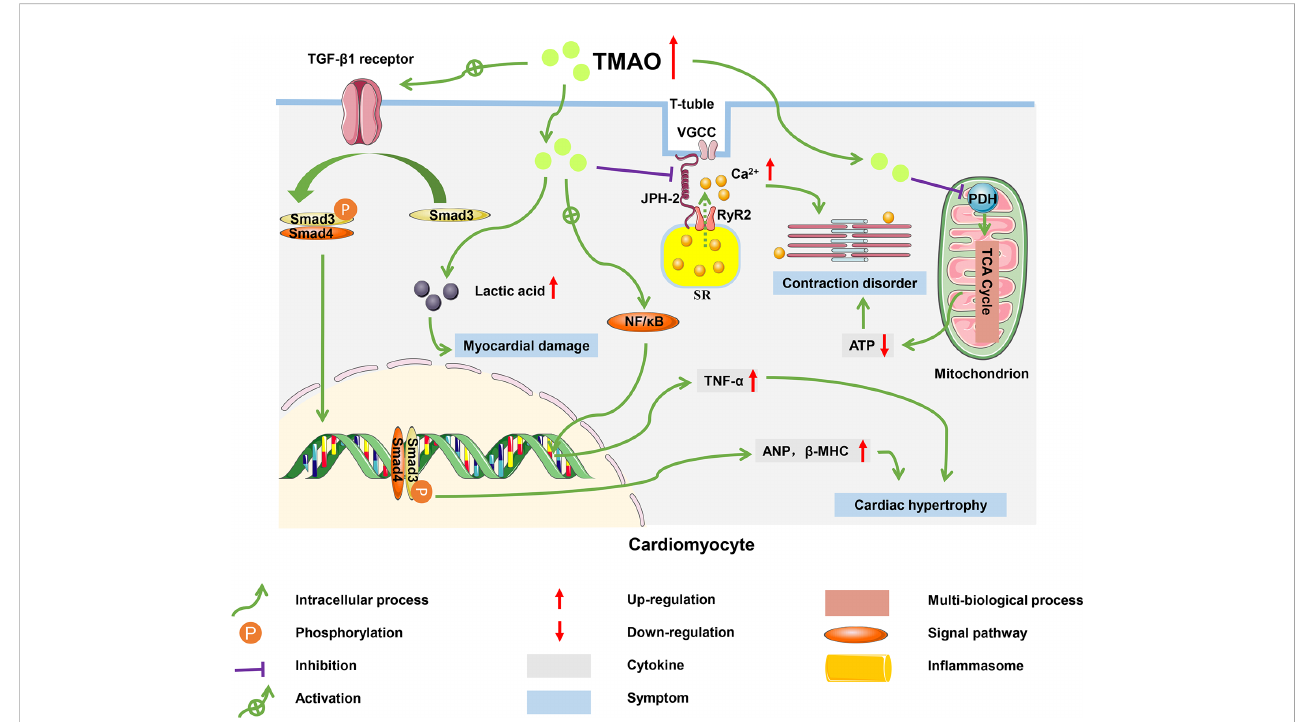
FIGURE 4 Molecular mechanisms of HF progression regulated by TMAO. In cardiomyocytes, TMAO activated TGF- b 1/Smad3 pathway and increased expression levels of ANP and b -MHC, which caused myocardial hypertrophy and fi brosis; TMAO decreased energy metabolism and mitochondrial function by inhibiting the activity of pyruvate, leading to myocardial damage; TMAO also negatively affected the intracellular Ca 2+ processing and myocardial